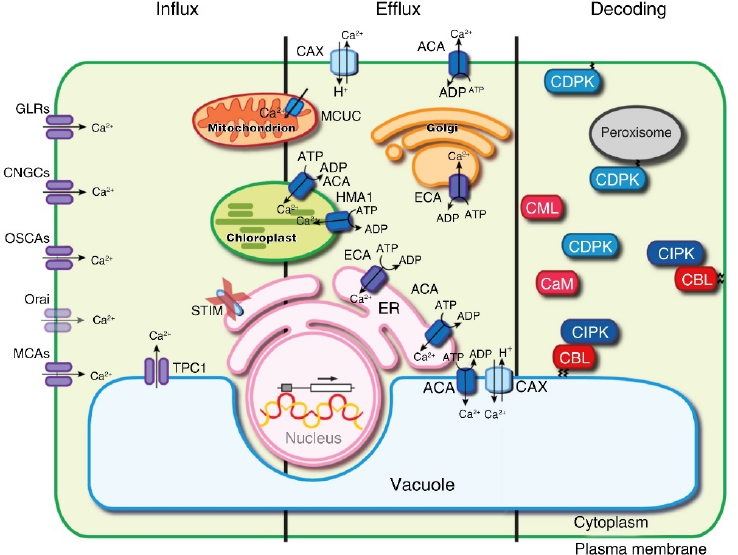
Figure 2. The generation and translation of Ca 2+ signals in plant cells. Three major processes, including influx, efflux and decoding, can alter the effects of Ca 2+ -signal translation. GLRs: